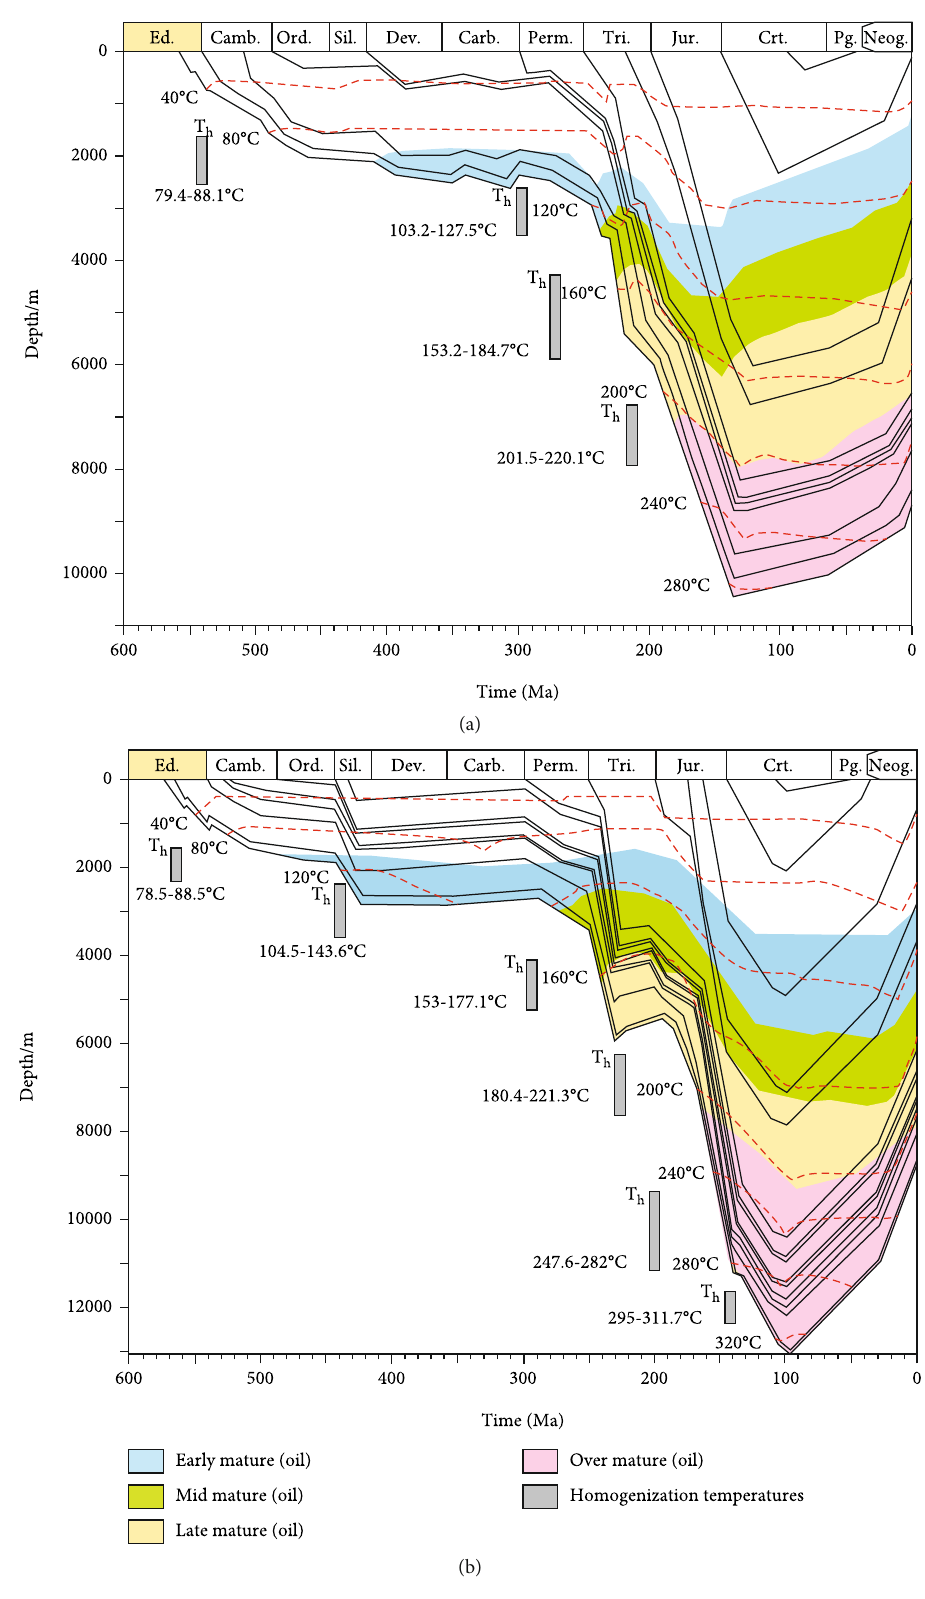
Figure 9: Burial thermal history of the two wells of the Sinian Dengying Formation: (a) CS well #1; (b) MS well #1, indicating approximately similar burial and thermal